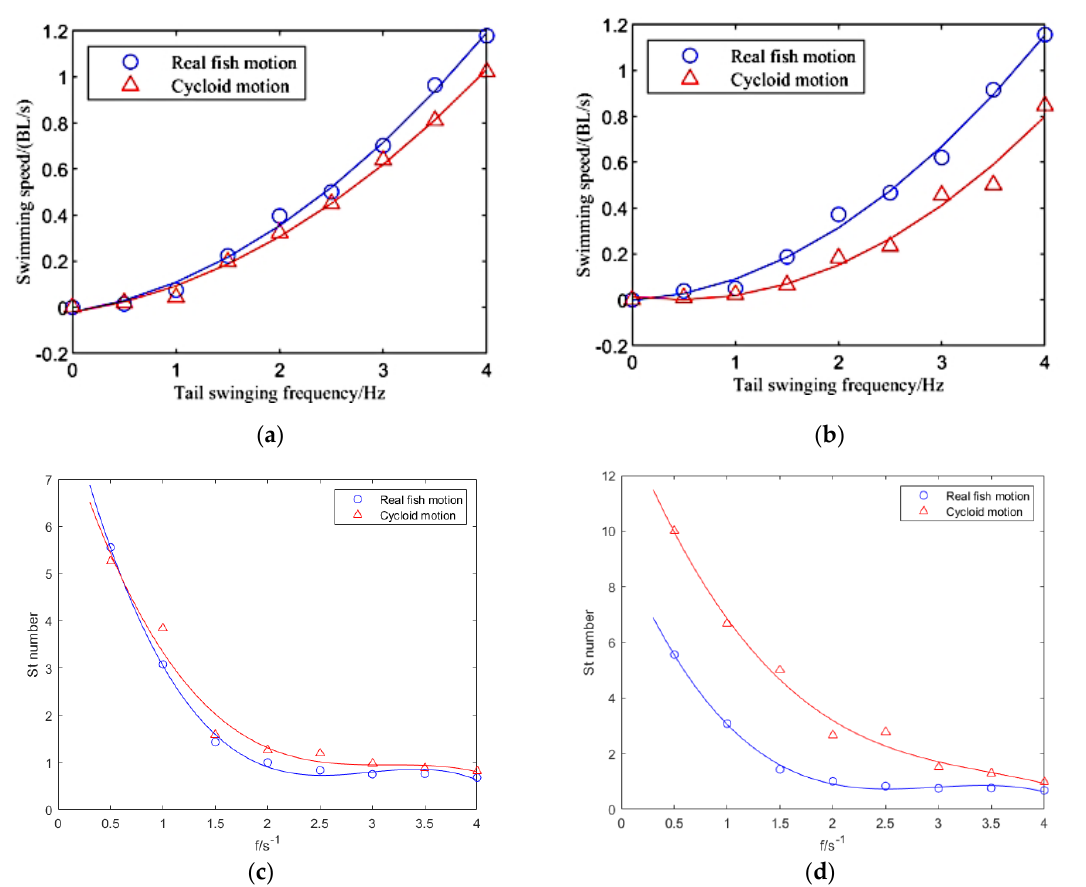
Figure 7. Velocity and St number of the fish robot when it swims in two motions at different frequencies. ( a ) Velocity of 1.5 mm-thick caudal peduncle. ( b ) Velocity of 2 mm-thick caudal peduncle. ( c ) St number of 1.5 mm-thick caudal peduncle. ( d ) St number of 2 mm-thick caudal peduncle.